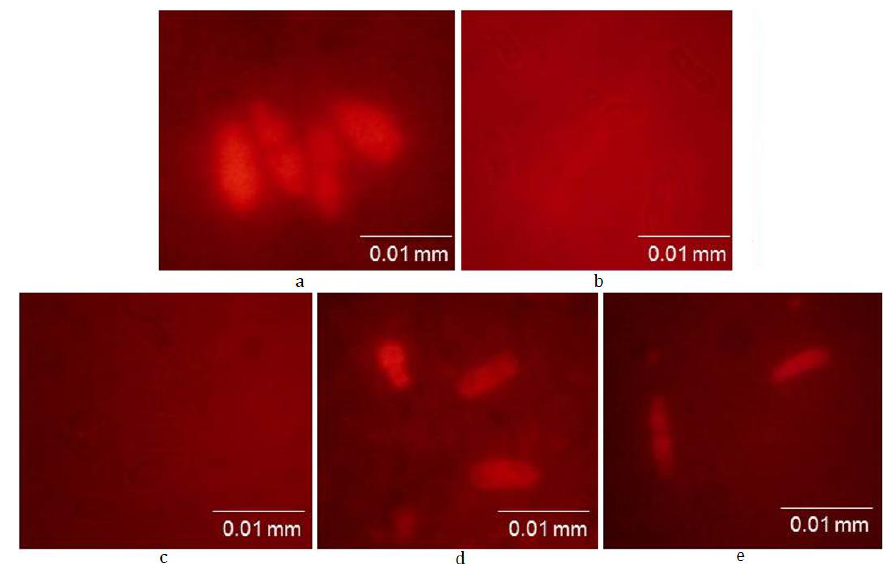
Figure 8. Effect of phytoexracts derived from the generative organ parts of X. granatum on mitochondrial activity of yeast S. pombe : (a) EMM 0.5% of glucose (control +, 0 µg.mL -1 ), (b) YES 3% of glucose (control -, 0 µg.mL -1 ), (c) YES 3% of glucose + 250 µg.mL -1 of seed phytoextract, (d) YES 3% glucose + 250 µg.mL -1 of flesh of fruit phytoextract, and (e) YES 3% glucose + 500 µg.mL -1 of peel of fruit phytoextract. Bar in each picture represents 10µm